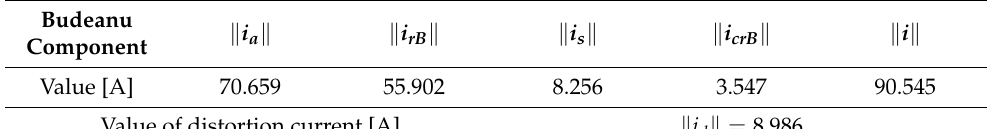
Table 5. List of RMS values of currents in developed Budeanu theory.